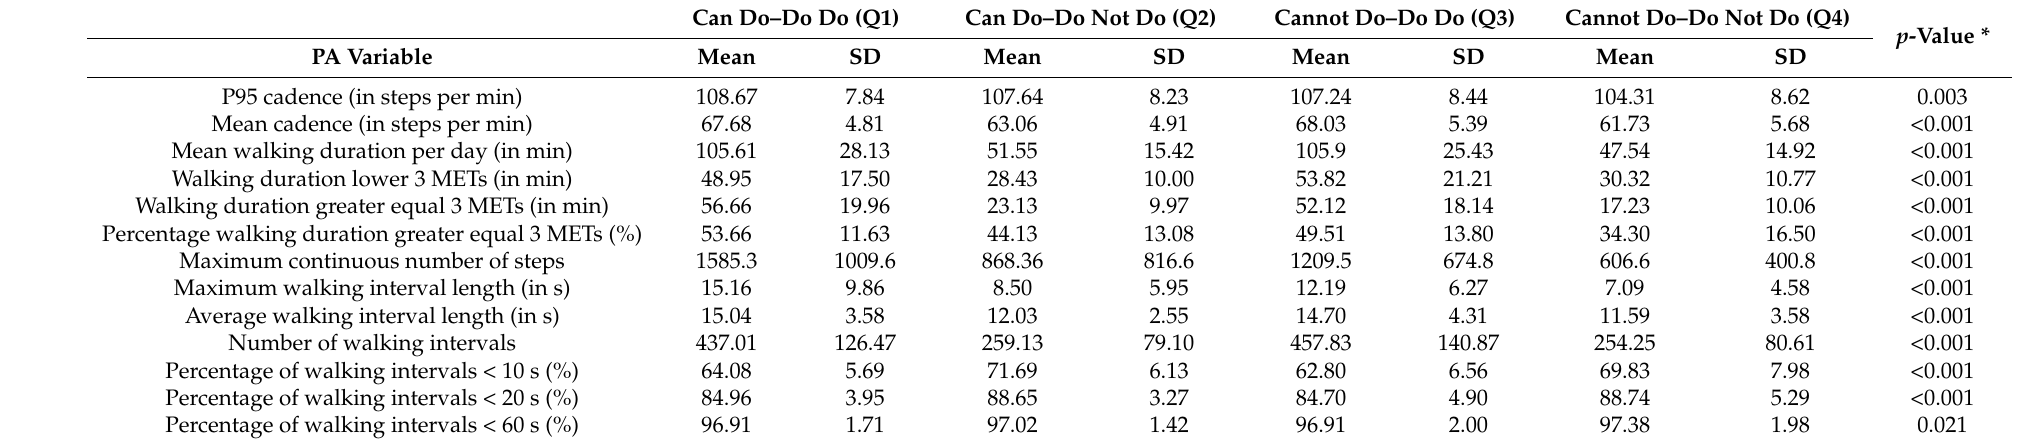
Table 3. Comparison of PA